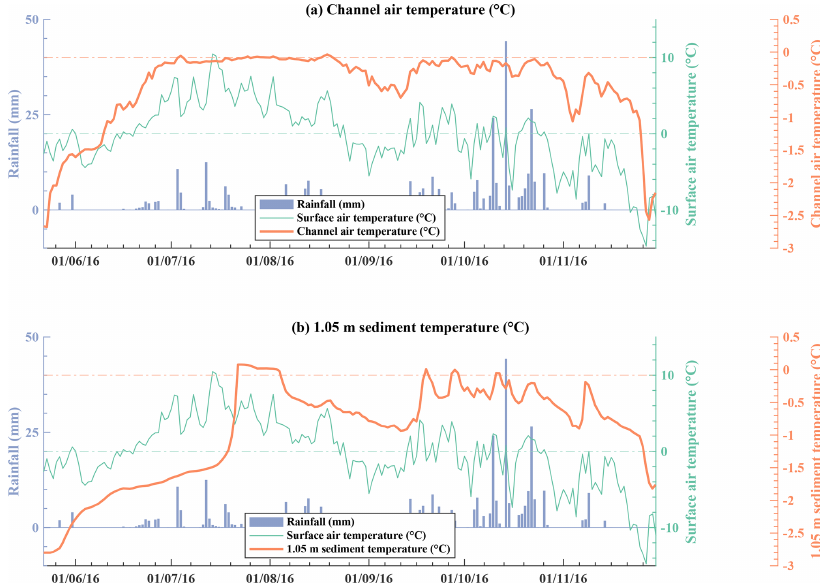
Figure 6. Daily subglacial temperatures compared to weather conditions at Larsbreen in 2016. (a) Time series of subglacial channel air temperature, modeled surface air temperatures and modeled rainfall. (b) Time series of subglacial sediment temperature, modeled surface air temperature and modeled